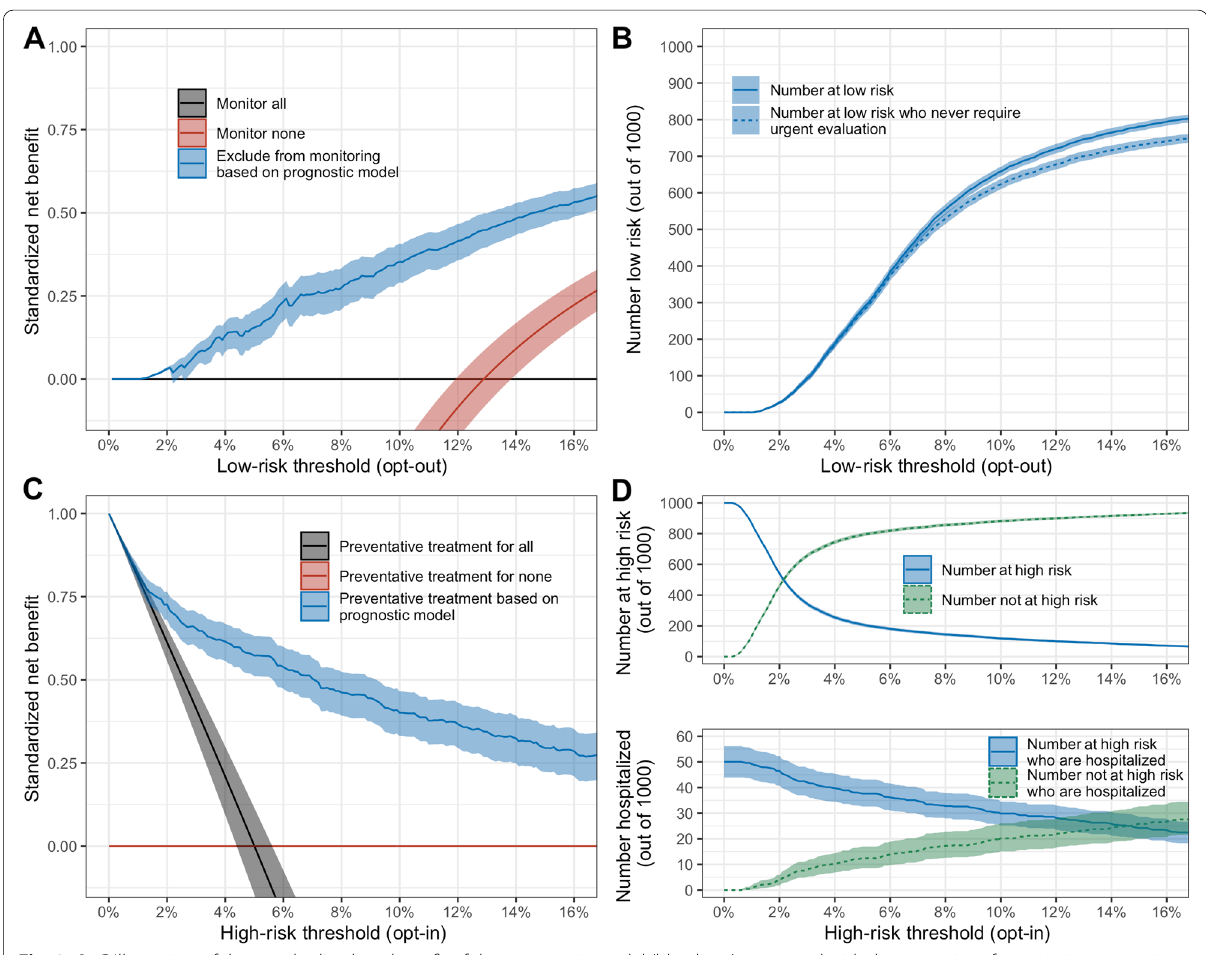
Fig. 3 A, C Illustration of the standardized net benefit of the prognostic model (blue lines) compared with the strategies of monitoring or treating all individuals (black lines) and not providing any follow-up or treatment (red lines) over a range of risk thresholds. B , D The number of persons (out of 1000) who would be categorized at high or low risk for each risk threshold. A The use of the prognostic model to omit persons from follow-up who are at low risk of an urgent care visit or worse. The Y -axis represents the net increase in the proportion of low-risk individuals who avoid unnecessary monitoring (out of a hypothetical maximum achieved when the true negative rate is one and false negative rate is zero) compared with the strategy of enrolling all persons. B Illustration of the expected number of individuals (out of 1000) who would be omitted from monitoring using the prognostic model as a function of low-risk threshold (blue line) and the number of persons who would be omitted and who would never require an urgent in-person evaluation or worse (dashed blue line). C The use of the prognostic model to offer individuals who are at high risk of hospitalization or worse more rigorous follow-up or therapeutic intervention. The Y -axis represents the net increase in the proportion of high-risk individuals who are offered treatment (out of a hypothetical maximum achieved when the true positive rate is one and the false positive rate is zero) compared with the strategy of treating no cases. D The expected number of individuals (out of 1000) who would be offered treatment (blue line) and not be offered treatment (dashed green line) as a function of high-risk threshold. Also shown is the expected number of high-risk individuals (blue line) and those not at high risk (dashed green line) who later would have required